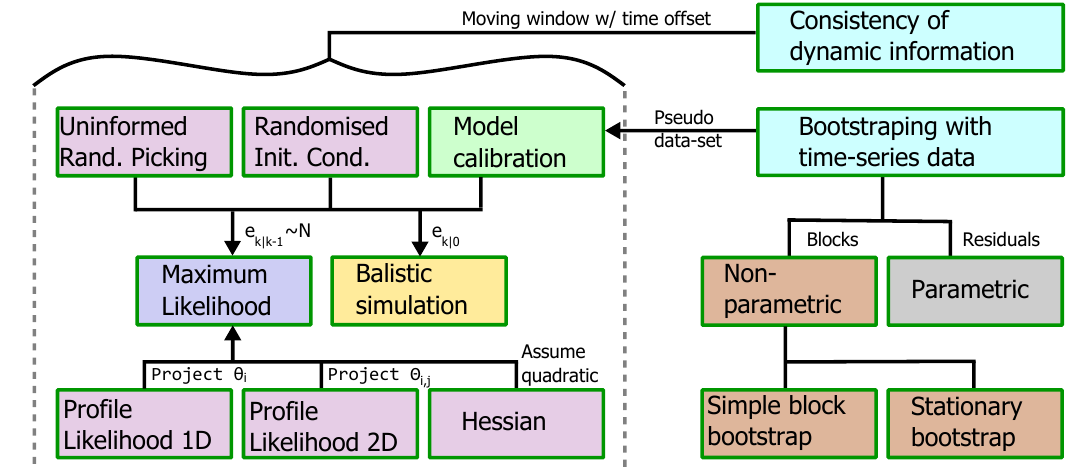
Figure 1: An overview of all the methods discussed in this paper, and how they are related. On the left-hand side, six optimisation based methods are shown, and related with the two types of objective functions that are discussed. The top three methods: Uninformed Random Picking, Randomised Initial Conditions and straight forward Model Calibration, can be used with both types of objective function. The lower three methods: Profile Likelihood 1D and 2D, and the Hessian curvature method, all require a Maximum Likelihood objective function. The top right block in the figure shows the moving window method, which can be used with all the six different methods to test the results for consistency in time. Next, the discussed variations of bootstrapping for time-series data are shown, and associated with model calibration, since the working principle of bootstrapping methods requires separate calibration of parameters for each generated pseudo data-set. Further, the two types of bootstrapping for time- series data, parametric vs non-parametric, are shown. Only non-parametric bootstrapping is discussed in this paper, specifically simple block bootstrapping and stationary bootstrapping, as illustrated in the lower right part of the